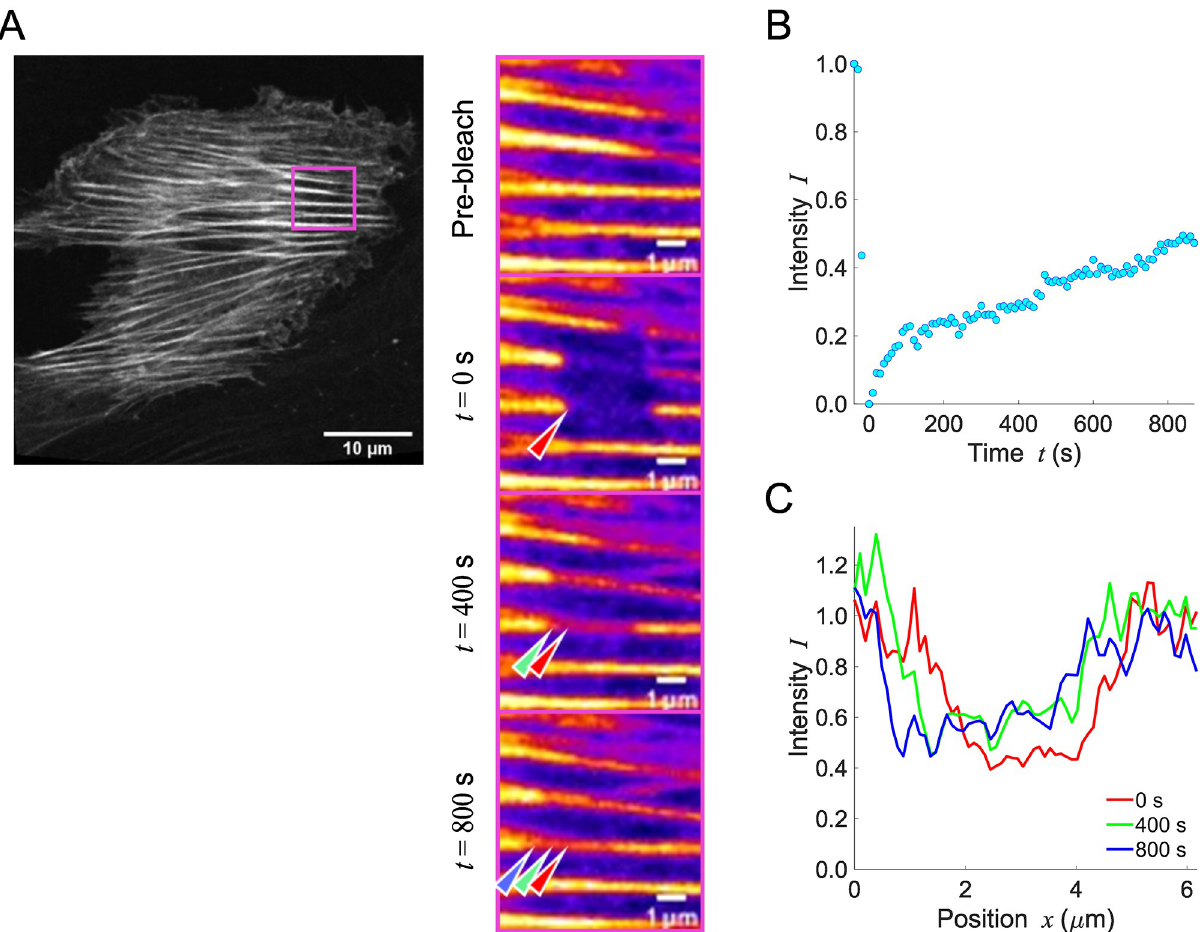
Fig 1. Long-term FRAP experiment is demonstrated to explain the importance of considering the effect of intracellular advection, where the intensity recovery in the fixed region of interest displays an abnormal curve. (A) The rectangular region in the left image (mClover2-tagged β -actin in an A7r5 cell) is magnified on the right panels, in which FRAP responses are shown. The arrow heads represent the bleached region that is being spatially shifted over time; red, green, and blue represent an identical part of the bleached rectangular region at t = 0 400, and 800 s after the photobleaching, respectively. (B) Time-series change in fluorescence intensity obtained based on a conventional approach using a spatially fixed region of analysis. The FRAP response is not properly approximated by the typical approach using exponential curves. (C) The intensity profiles along the length of a single SF in a spatially fixed frame at t = 0, 400, and 800 s. Scale, 10 μ